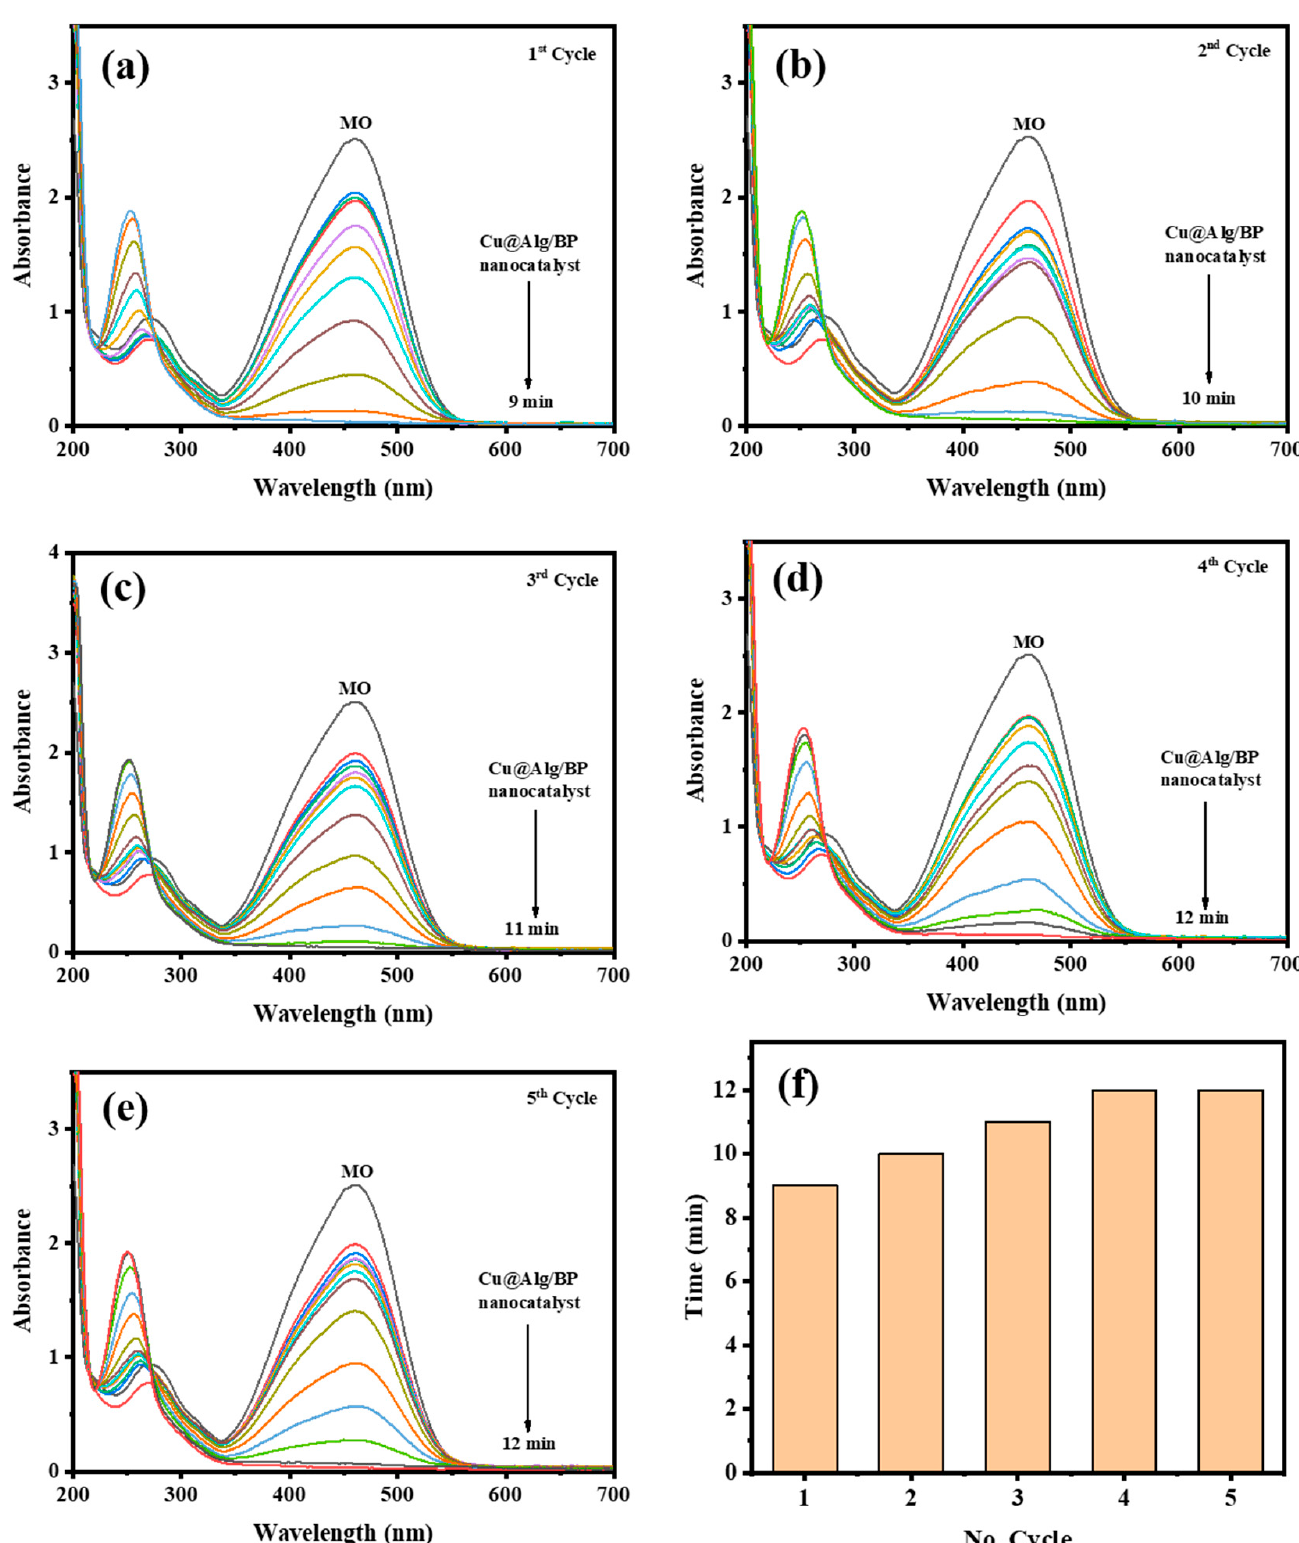
Figure 9. ( a – e ) Time-dependent UV–Vis spectra for MO reduction by NaBH 4 using 3 beads of Cu@Alg/BP nanocatalyst five times. ( f ) Recyclability of Cu@Alg/BP nanocatalyst for MO reduction.